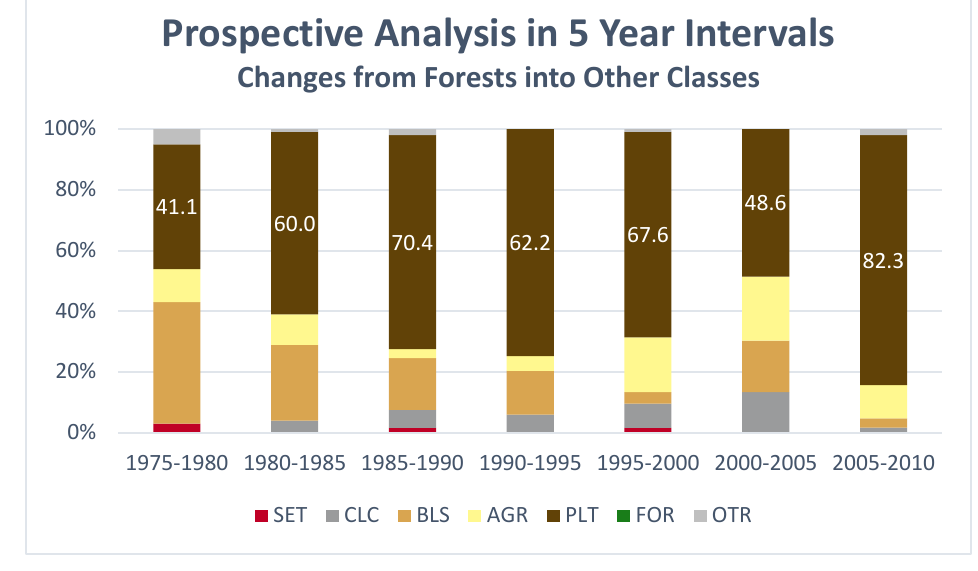
Figure 6. Prospective analysis in five-year intervals focusing on forests. The percentages show which land use systems forests lost during the interval have been converted.